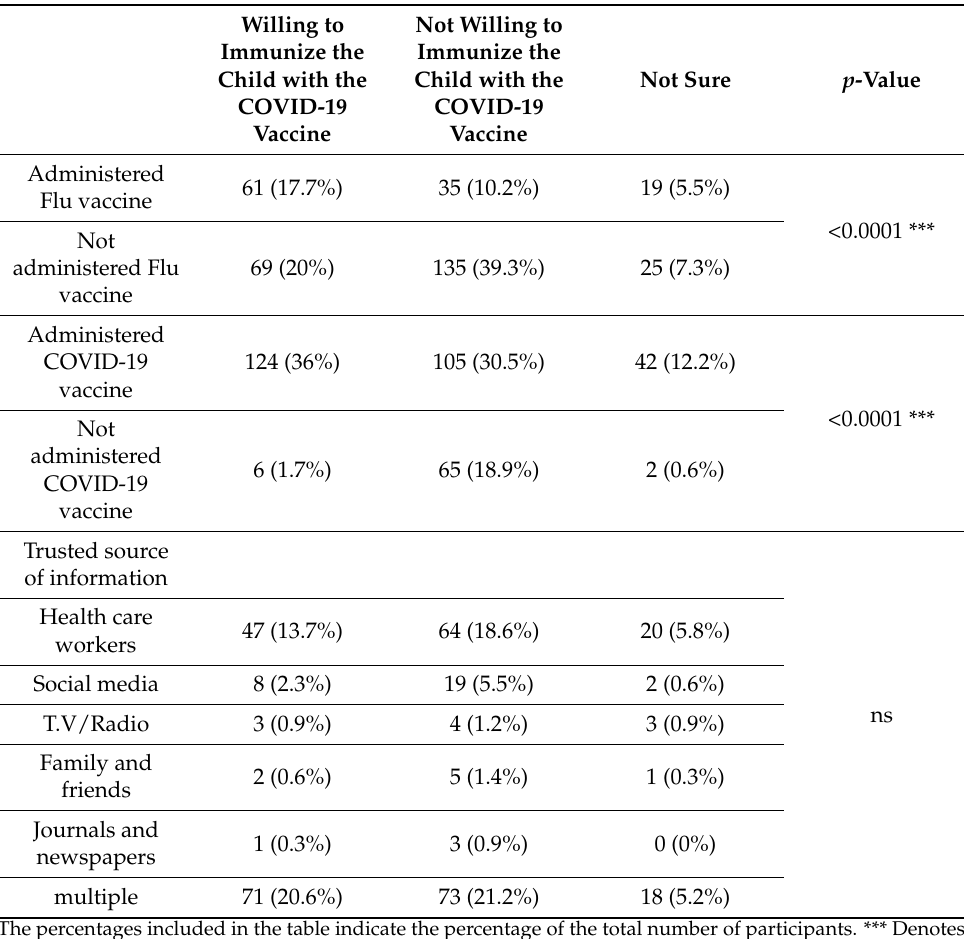
Table 4. Participants’ willingness to vaccinate based on their previous vaccination and trust source of information.